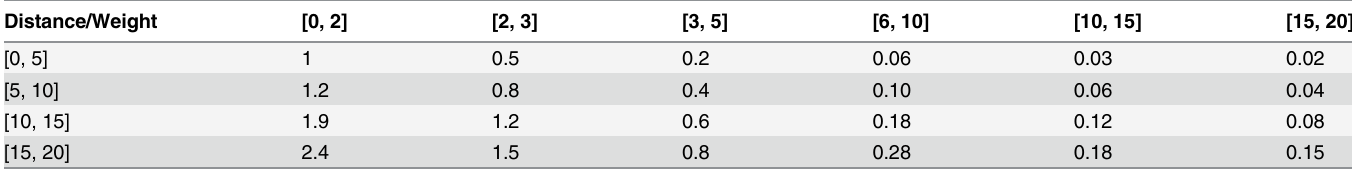
In that equation, CoordX is the mapped value of the blood ’ s weight, CoordY is the mapped value of the distance. Now, MaxX and MinX are maximum and minimum loadage respectively, while MaxY and MinY are maximum and minimum fl ight distance respectively. However, since the weight of blood and hot water may exceed the carrying capacity of the UAV during transit, there may exist some nodes which cannot be accessed in the data set. In the experimental process, the starting point also can be considered as a destination point, since the blood requirement and the flight distance is zero, so we have MinY = MinX = 0 here. When mapping the blood weight, if the weight of blood is close to the MaxX , the minimum ratio of the weight of hot water to the weight of blood can be set as 0.02:1. In order to ensure that the weight of blood and hot water will not exceed the maximum carrying capacity of the UAV, the MaxX can be set as w / (1 + 0.02). As for the mapped value of distance MinY , we can set it directly for different data instances. It can be seen from Table 5 that the change of the proportion is not uniform; the proportion value increases along the time axis from small to large and decreases with the blood weight. Table 5. Proportions between hot water and blood.